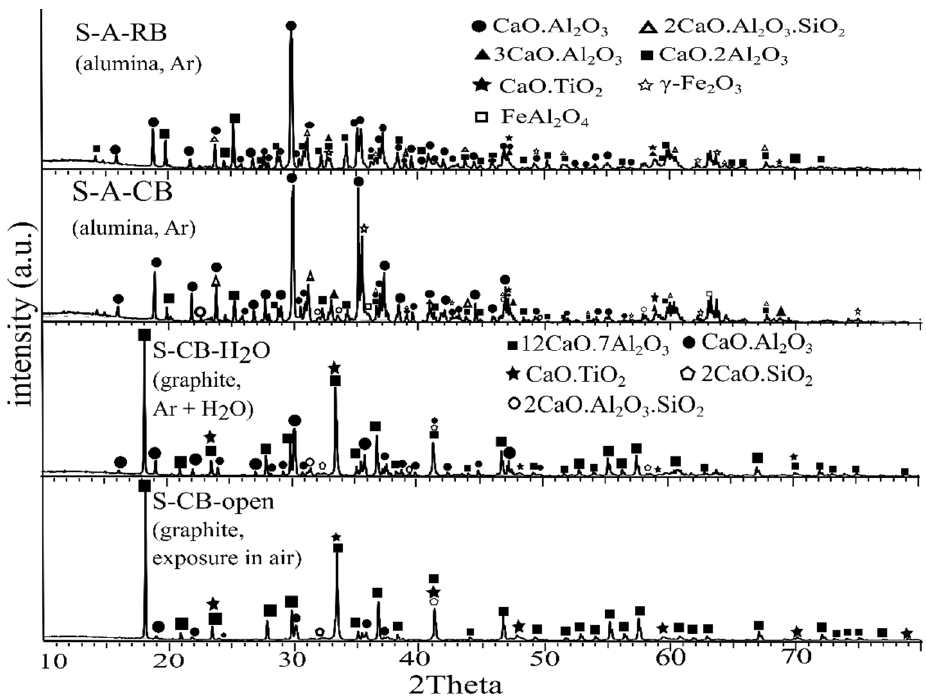
Figure 10. XRD analysis of the slags obtained from the studied atmospheric conditions in different crucibles.